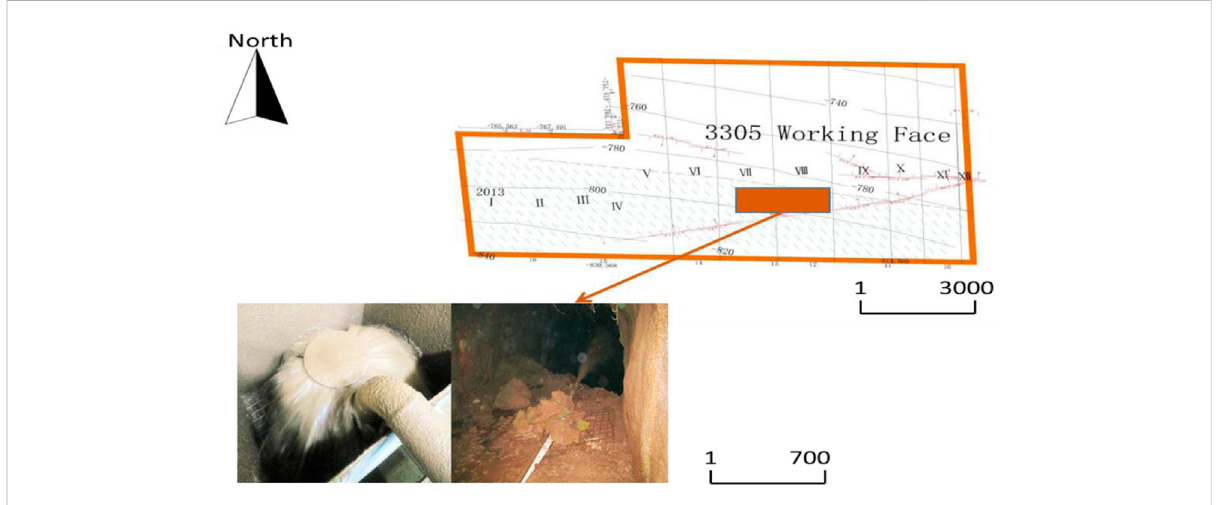
FIGURE 1 3305 mining area working face layout and mining area fi lling site.